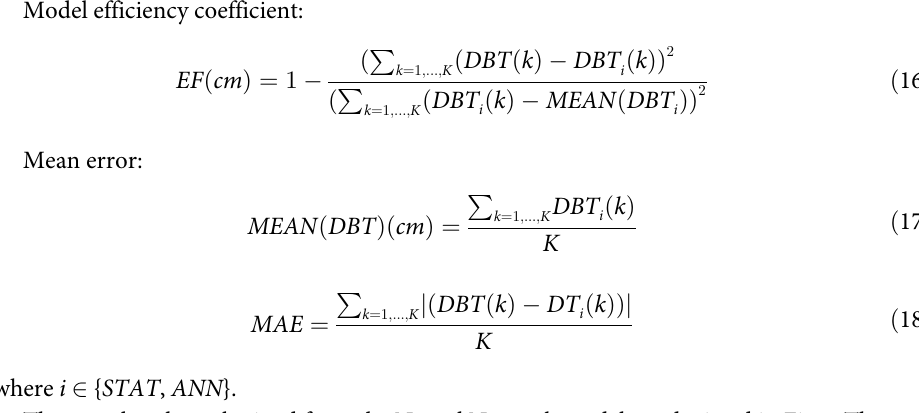
PLOS ONE | https://doi.org/10.1371/journal.pone.0276798 November16,